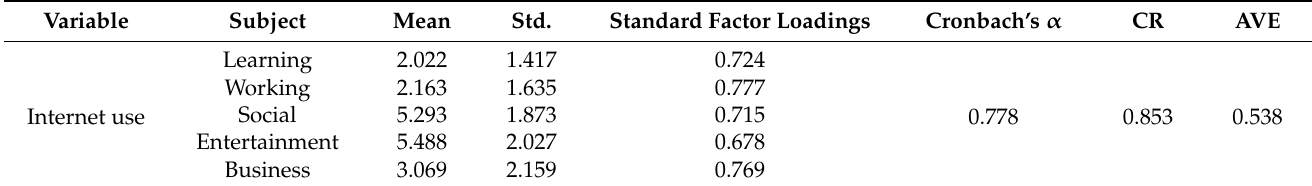
Table 3. Description of Internet use.